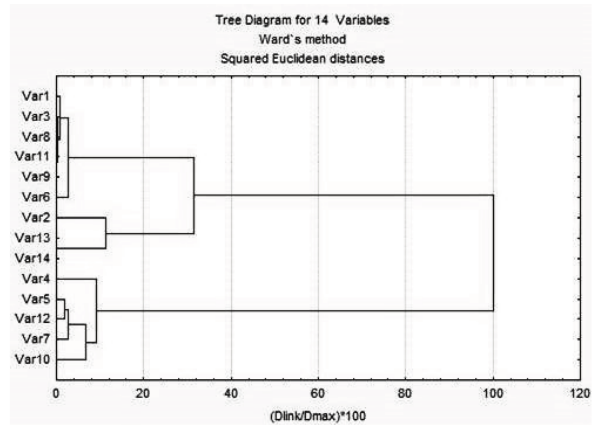
Figure 2: Hierarchical dendrogram of 14 variables describing different glass